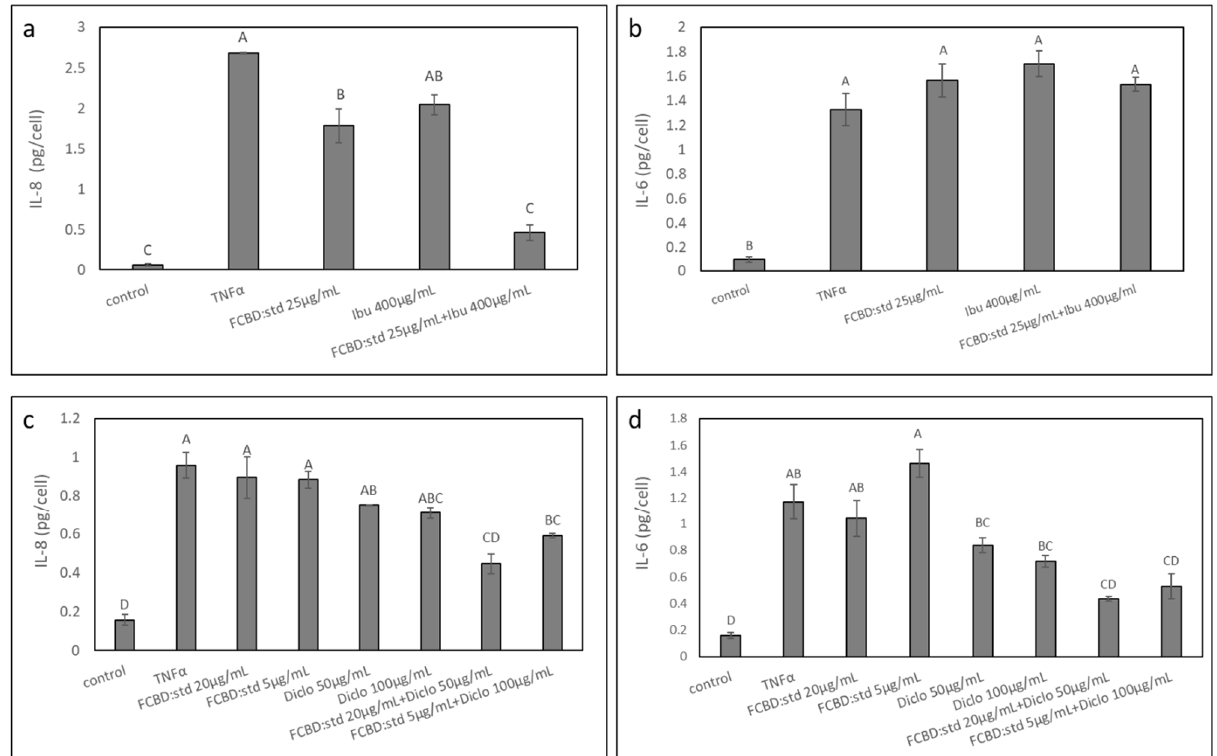
Figure 8. The effect of treatments with FCBD:std and/or ibuprofen ( a , b ) and FCBD:std and/or diclofenac ( c , d ) on IL-8 ( a , c ) or IL-6 ( b , d ) levels in a 3D co-culture model of A549 monolayer and differentiated KG1 cell lines in ECM. Control is vehicle control (1% methanol and 1% DMSO for Ibu and Diclo, respectively). TNFα is solvent control + TNFα. Means ± SE ( n = 3) are shown. Levels of means with different letters are significantly different from all pairs’ combinations according to the Tukey–Kramer honest significant difference test (HSD; p ≤ 0.05).